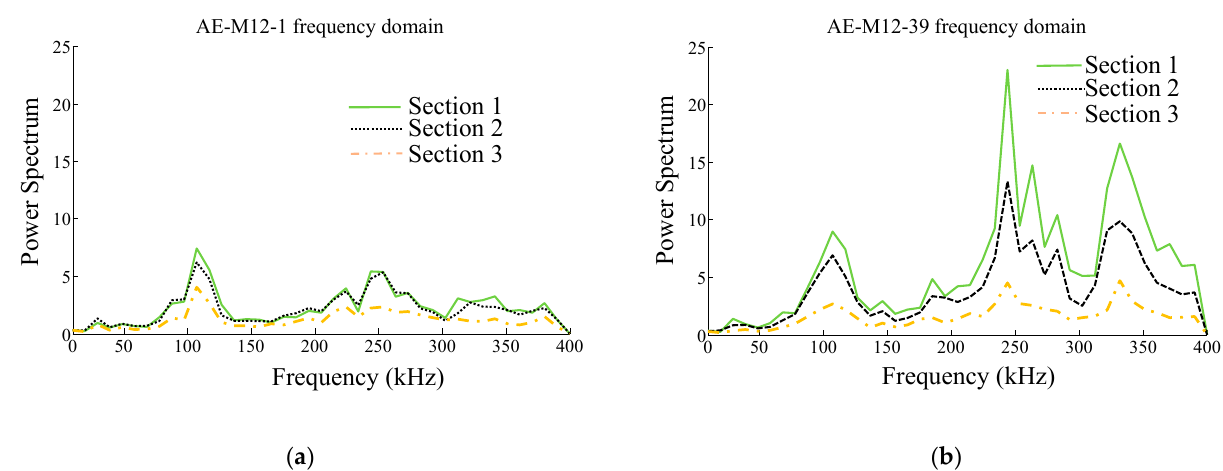
Figure 8. Frequency-domain AE signals collected during laser microwelding for different 1 ms intervals of the welding process: ( a ) low and ( b ) normal bonding strengths.